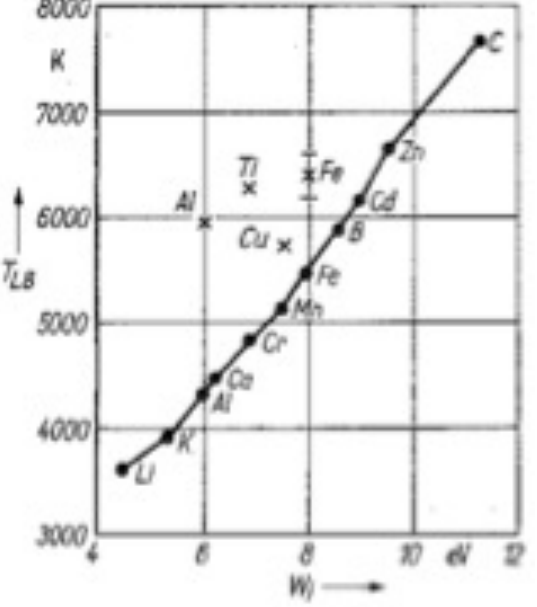
Figure 6. Average arc temperature over the ionisation potential of the elements [30].